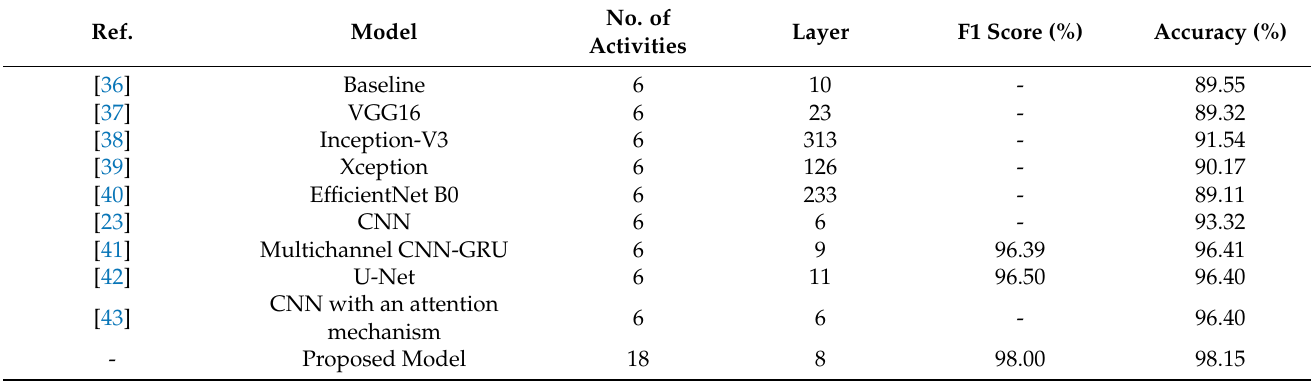
Table 5. Evaluation of the proposed model in comparison with models based on CNN.